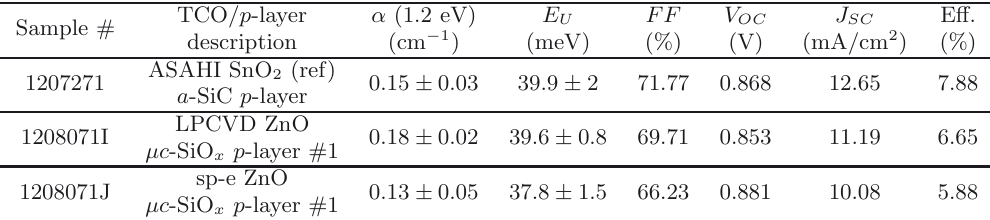
Table 1. Initial photovoltaic parameters of pm -Si:H p - i - n devices fabricated on three different TCO substrates along with the absorption coefficient and the Urbach energy of their intrinsic pm -Si:H layer. All the cells incorporate the same i - pm -Si:H (300 nm) and n - a -Si:H layers and evaporated Al back contacts.